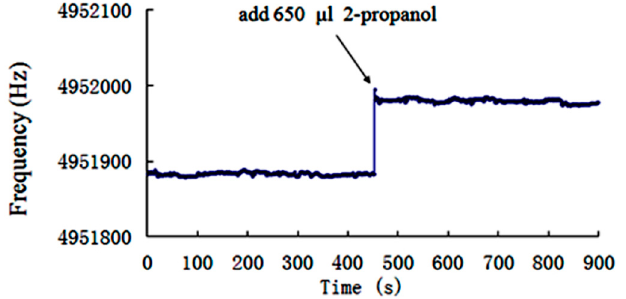
Figure 7. Frequency time responses of the LGT LFE device in aqueous solutions of 2-Propanol with a minor concentration variation (the initial concentration is 60%).